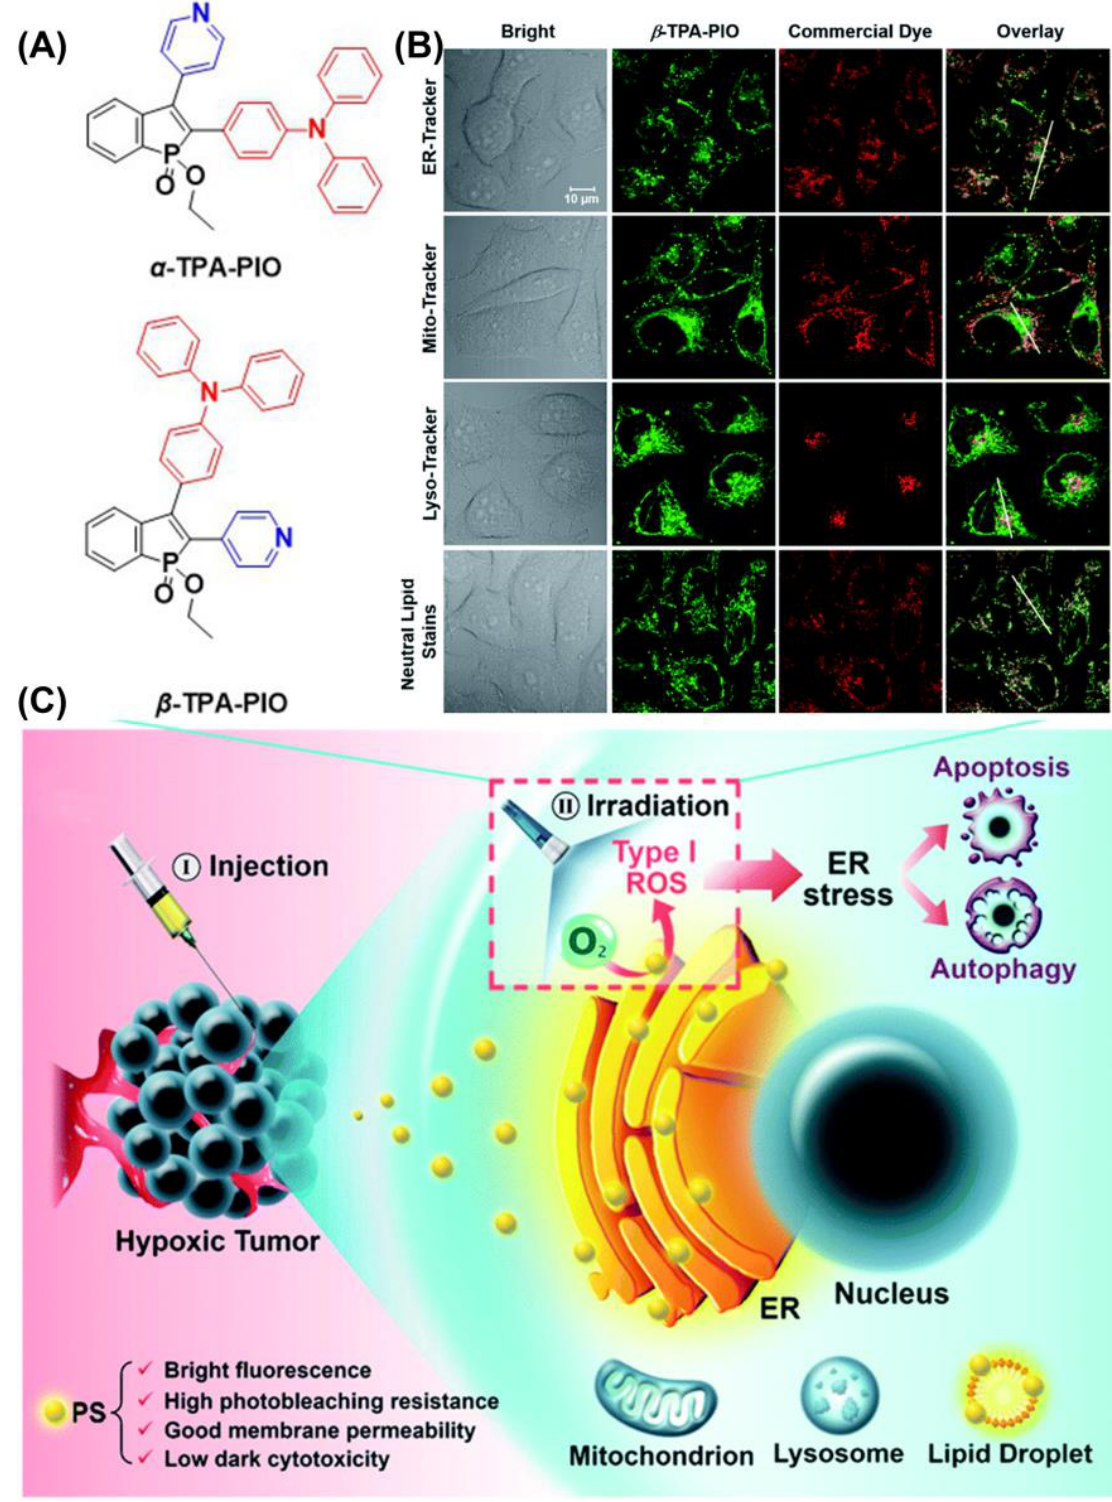
Figure 15. ( A ) Chemical structure of α -TPA-PIO and β -TPA-PIO; ( B ) CLSM images of HeLa cells co-stained with β -TPA-PIO; ( C ) schematic illustration of PDT treatment treated with PIO-based PSs. Reprinted with permission from Ref. [128]. Copyright 2020 Royal Society of Chemistry.